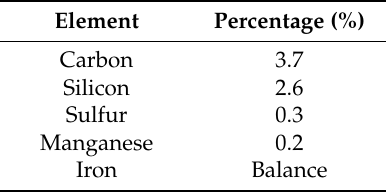
Table 1. Constituents proportion of ductile cast iron.